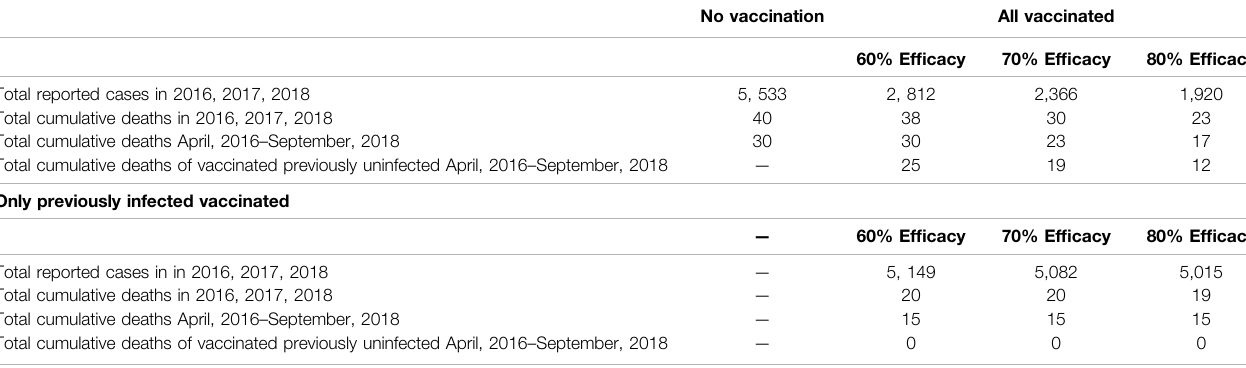
TABLE 6 | Values of reported cases and cumulative deaths of vaccinated 9 year old children